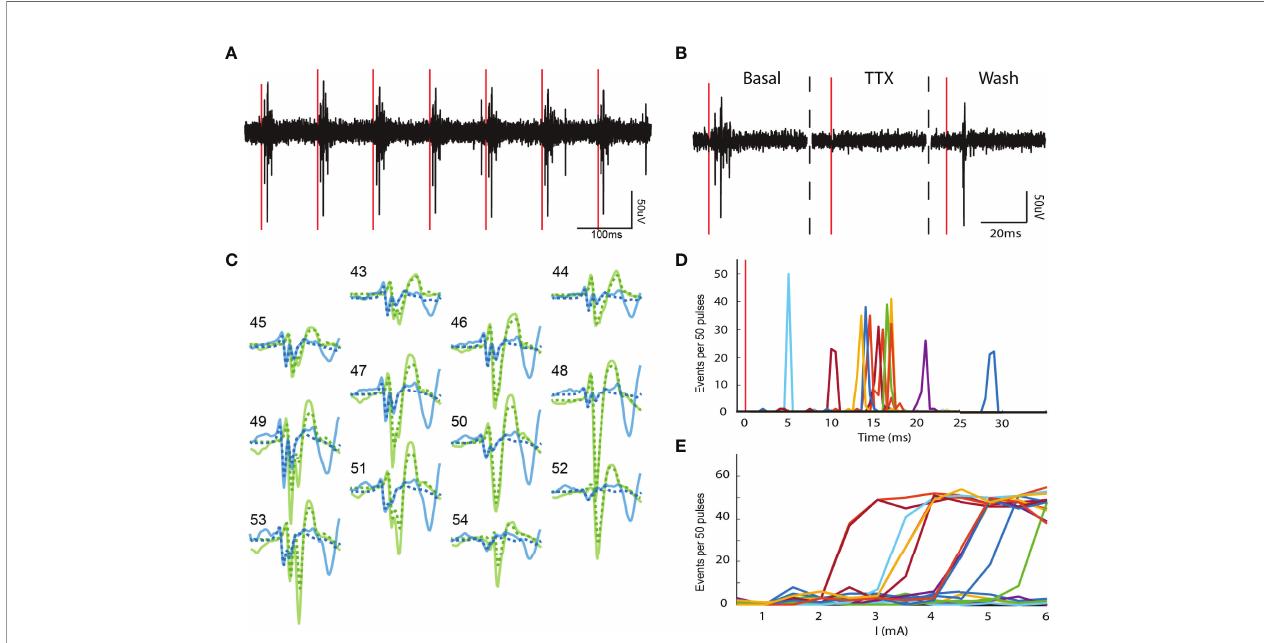
FIGURE 5 | Electrically evoked chromaf fi n cell activity. (A) Electrical stimulation of the splanchnic nerve evokes activity in the adrenal medulla. Representative recording of a single phase 10Hz-3.5mA stimulation train (red vertical lines). (B) The local application of TTX to the splanchnic nerve reversibly blocked the evoked action potentials in the adrenal medulla. (C) Evoked templates (solid lines) from two units. The evoked templates are identical to their spontaneous counterparts (dotted lines). (D) The evoked units present distinct latencies that range from 5 to 30 ms after the stimulus (red vertical line). The data are from the same experiments as in panel (C) . (E) Distinct networks have different stimulus thresholds. The stimulus intensity was gradually increased from 0 to 6 mA in 0.5 mA